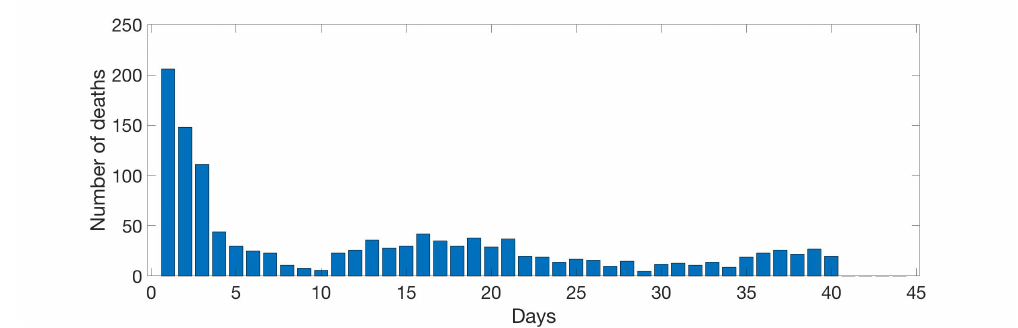
Figure 12. Evolution of the animal death count per day. Data evaluated daily by the farm management.